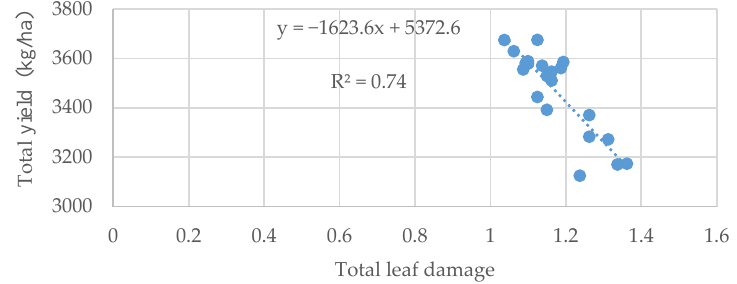
Figure 4. Correlation between total leaf damage and total